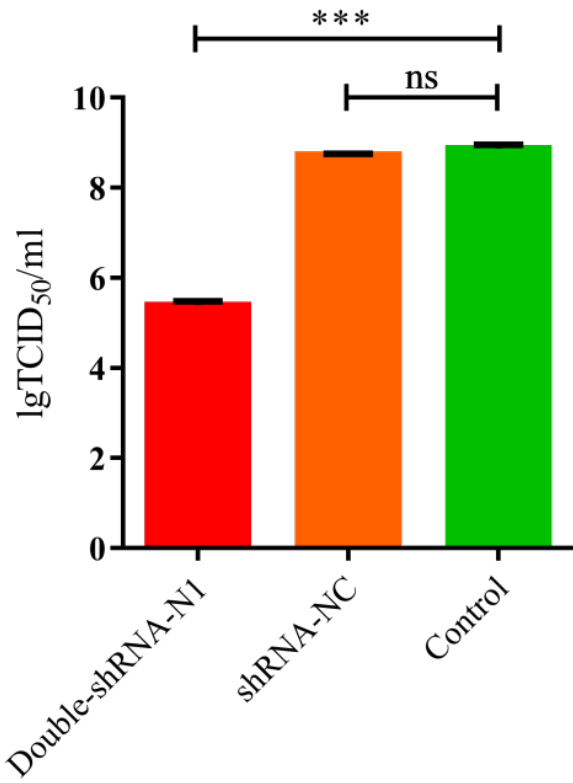
Figure 6. TCID 50 determination of PDCoV on pSil-double-shRNA-N1-mCherry-transfected LLC-PK1 cells collected at 36 hpi. As indicated, the titer of PDCoV in pSil-double-shRNA-N1-mCherry- transfected LLC-PK1 cells is much lower than the other treatment groups of cells. Viral titers are shown by TCID 50 . The data are presented as the mean values ± standard deviation from three re- peated experiments, are marked with one asterisk (***) if p < 0.001.